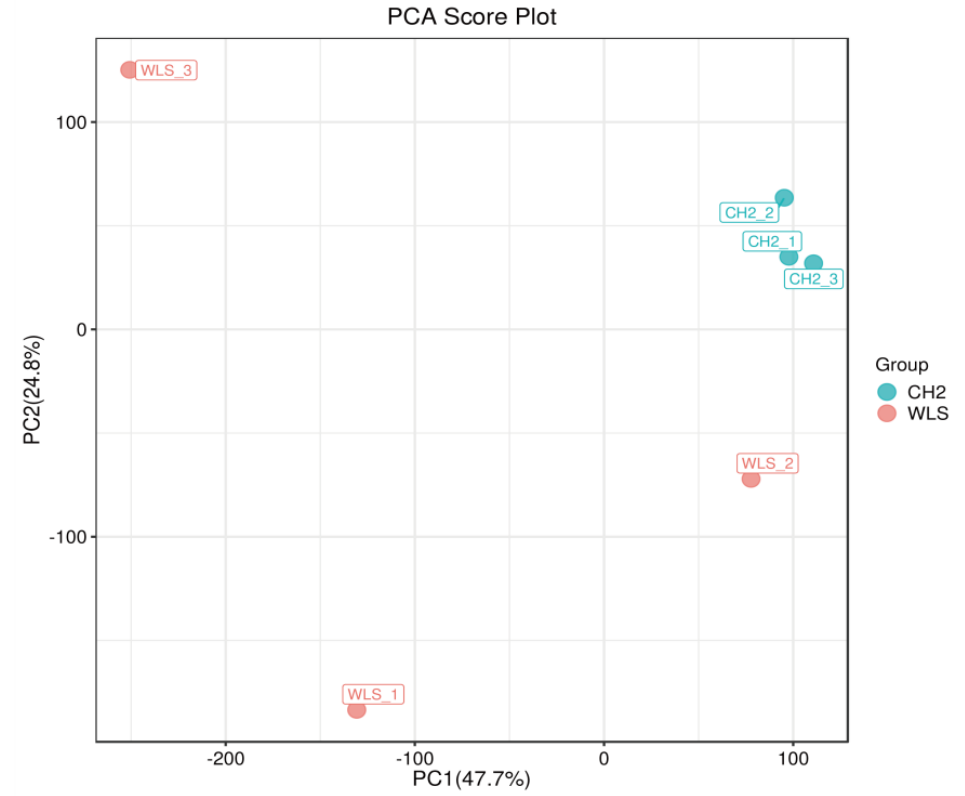
Figure 3. Principal component analysis (PCA) score plot. PC1: the first principal component epla − nation; PC2: the second principal component explanation. The dots represent the samples. Red dots represent the WLS group, and blue dots represent the CH2 group.